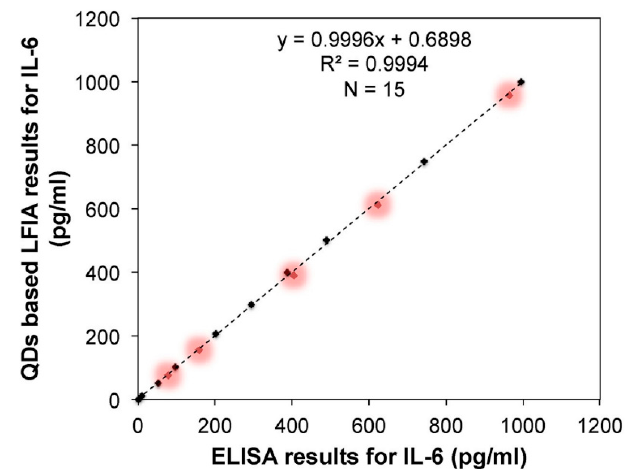
Figure 19. Comparison of lateral flow immunoassay (LFIA) results with standard enzyme-linked immunosorbent assay (ELISA) results. Black points correspond to IL-6 detection in Tris buffer while points highlighted in red correspond to IL-6 spiked in human serum. Reprinted [149], 2019), Copyright 2019, with permission from Elsevier.